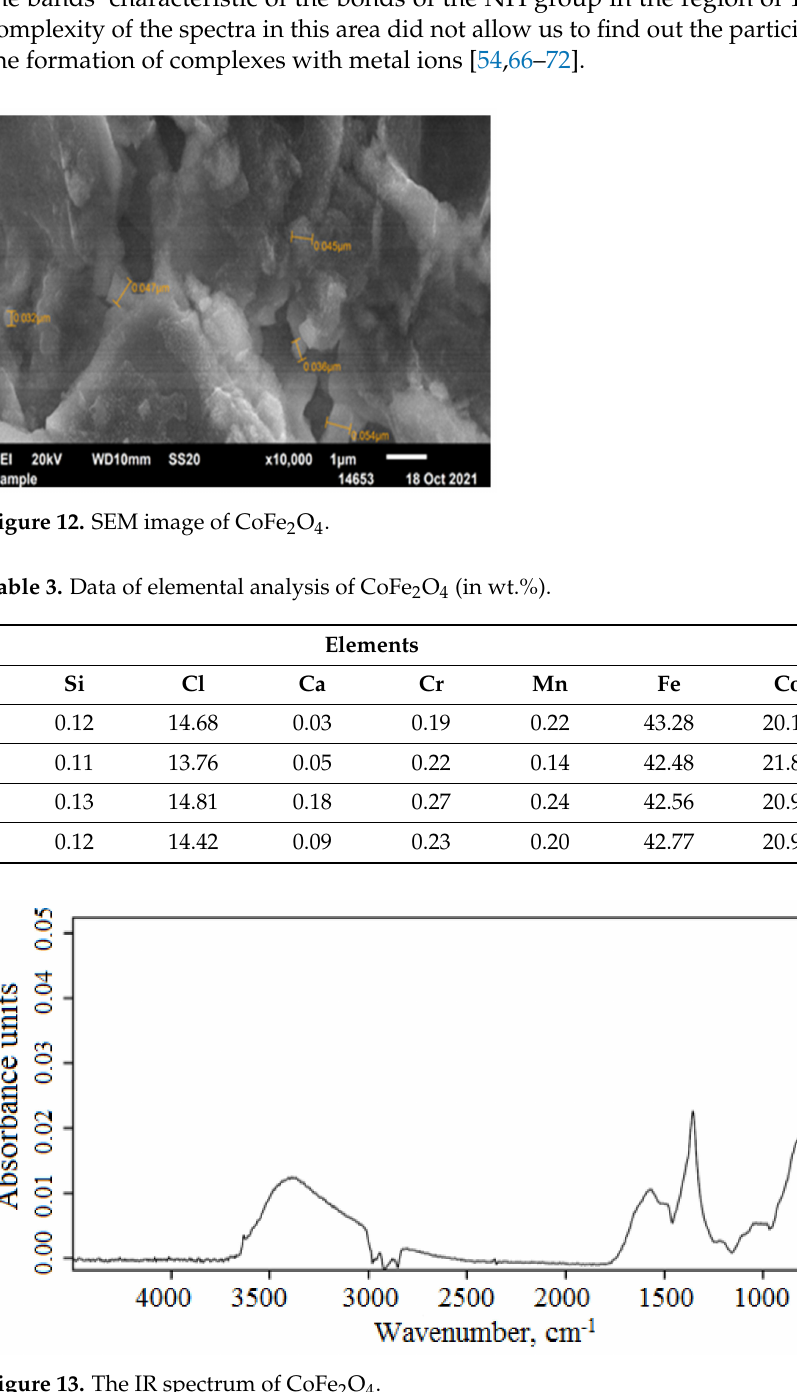
Figure 13. The IR spectrum of CoFe 2 O 4